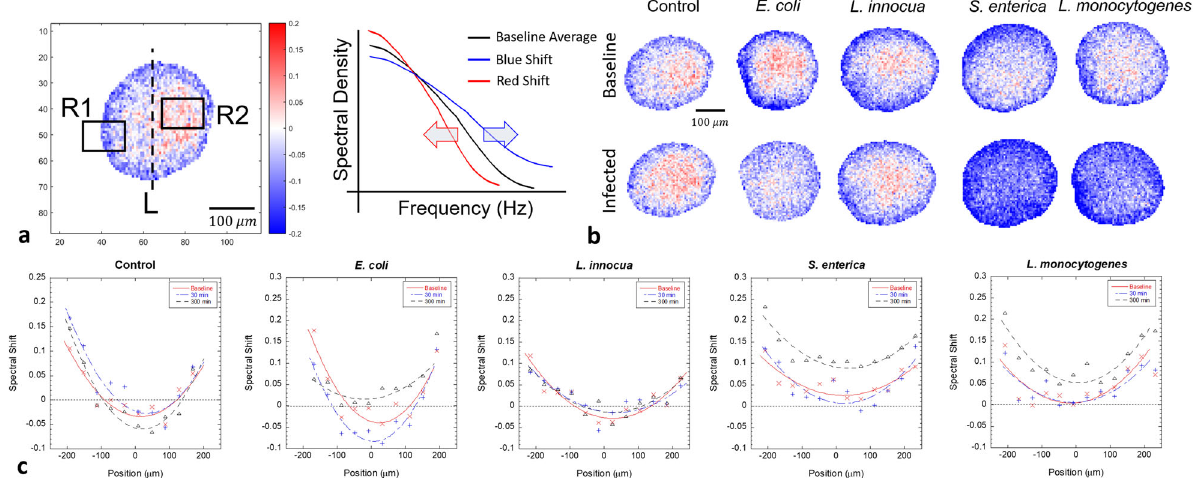
Fig. 4 Representative cases of tissue-dynamics spectroscopic images (TDSI) of bacterial invasion of 10 7 CFU into a DLD colon adenocarcinoma tumor spheroid. a The linear fi lter used here measures red or blue shifts of spectral shape (zero-sum normalization). The untreated control displays a small blue shift (blue colored) in the outer layers (R1) and a small redshift (red-colored) in the core (R2) over the duration of the experiment (5 h). b L. innocua is indistinguishable from the control. S. enterica and L. monocytogenes display strong blue shifts throughout the volume within 300 m after infection. The blue shift for E. coli is intermediate between the pathogenic strains and the control. The scale bar applies to all other speckle images in b . c One-dimensional plots of TDSI along the axis L in a . The pathogen group ( L. monocytogenes and S. enterica ) display blue shifts throughout the volume. The y axis represents the relative change in average Doppler frequency (knee frequency of the spectrum) The two pathogenic strains induce approximately a 15% increase in intracellular